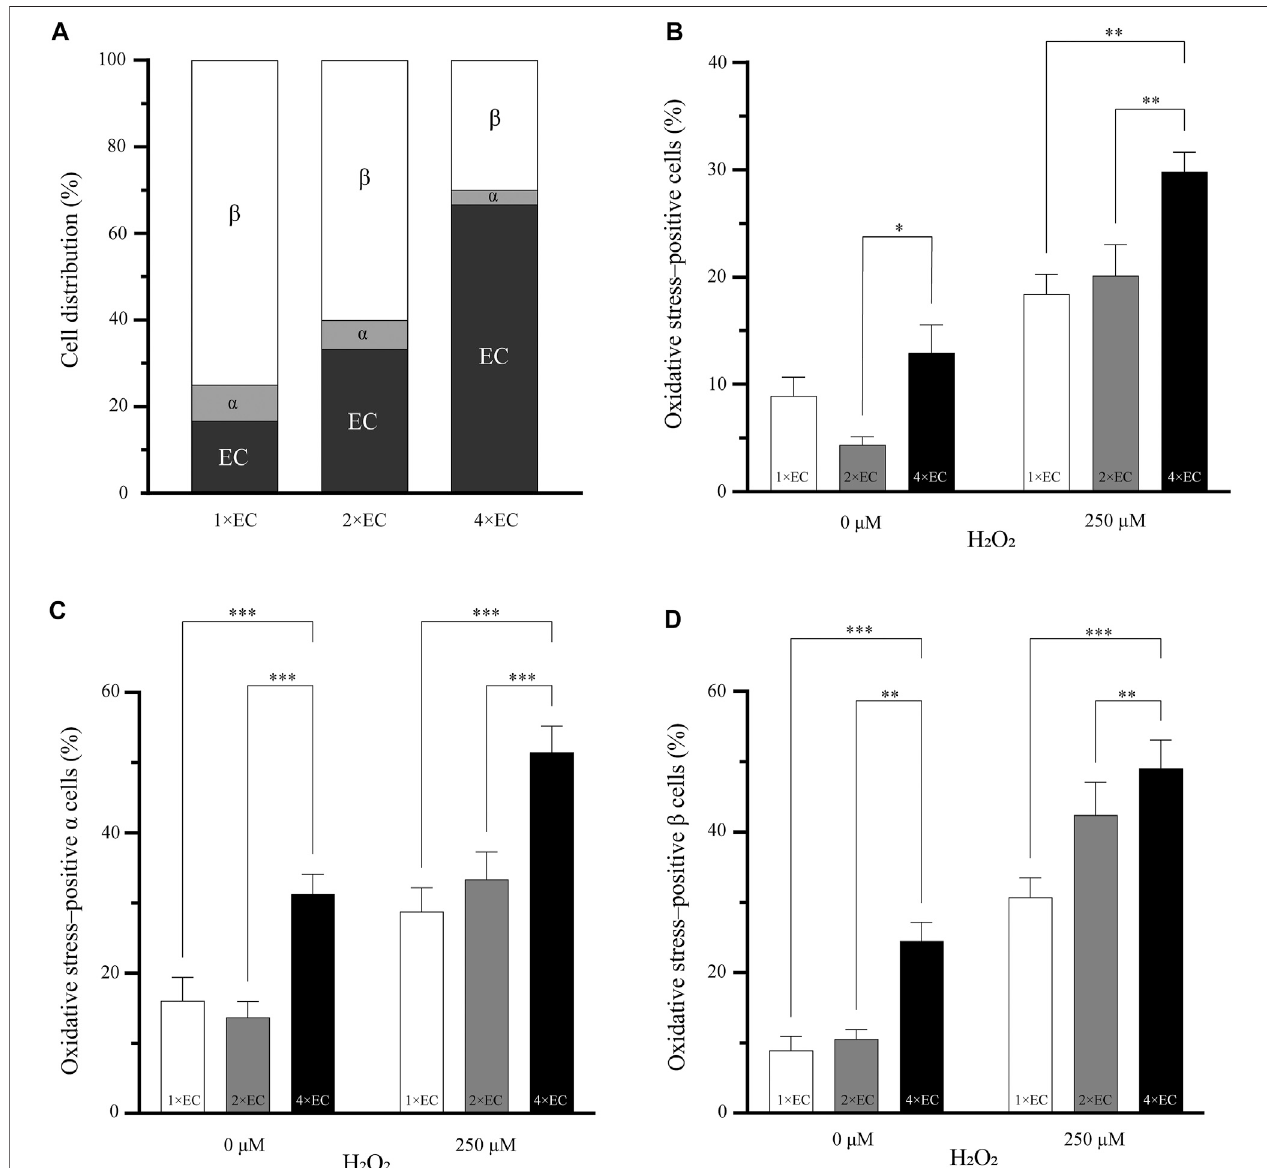
FIGURE 3 | Increasing the number of endothelial cells does decrease the percentage of oxidative stress – positive cells (A) Three different seeding conditions of endothelial cells were used to understand if the number of endothelial cells can in fl uence the oxidative stress in the pseudoislet. The cell ratio between α and β remained the same in all three conditions (B) The two pseudoislets (1 × and 2 × ) with the fewest endothelial cells had a signi fi cantly lower number of oxidative stress-positive cells than the 4 × pseudoislet with the induction of oxidative stress (* p < 0.03, ** p < 0.008) (C, D) Looking at the α and β cells, there were signi fi cantly more oxidative stress-positive cells (** p < 0.01, *** p < 0.001) in the 4 × pseudoislets. Results are expressed as mean ± SEM, and each data set includes twelve pseudoislets (n:12), and the experiment was repeated three times